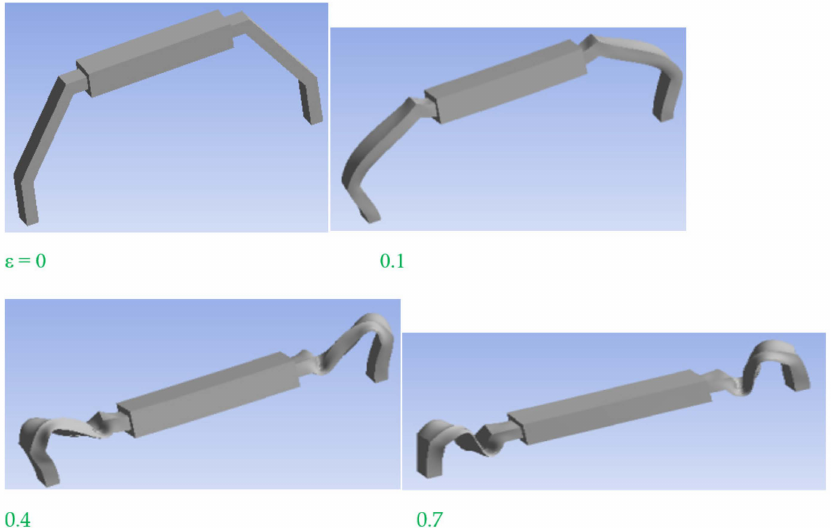
Figure 8. Simulation deformation